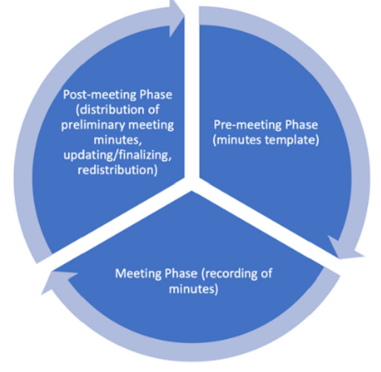
Figure 1. Meeting minutes lifecycle.